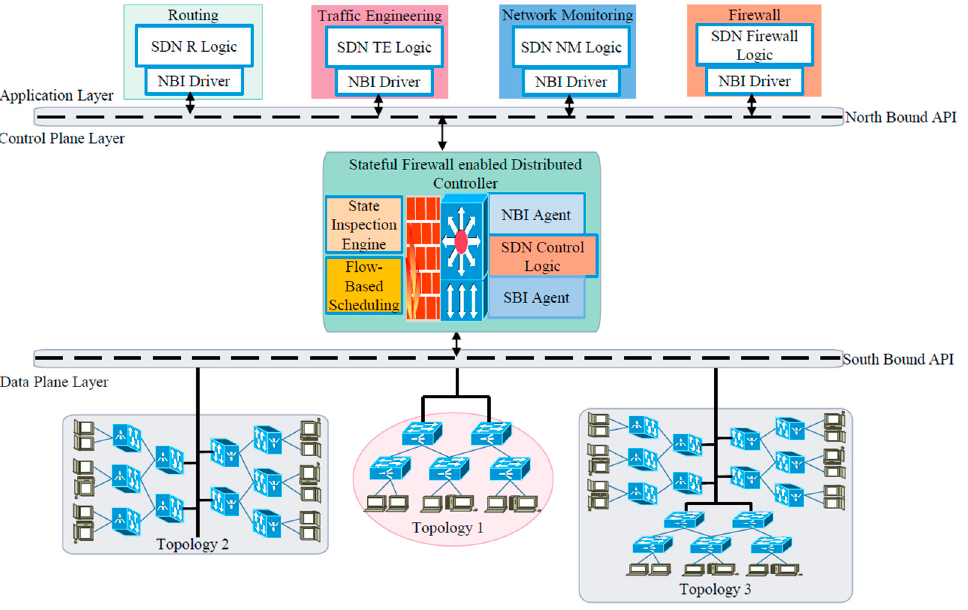
Figure 3. Stateful firewall-enabled single centralized SDN controller.